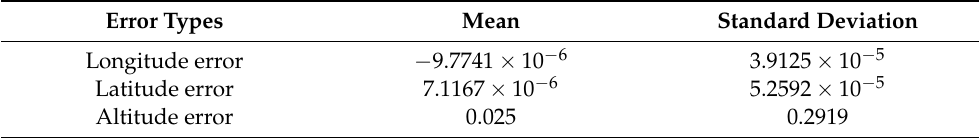
Figure 16. Errors between detected results and the manual measurement results: ( a ) longitude errors; ( b ) latitude errors; ( c ) altitude errors. Table 4. The mean and standard deviation of errors.